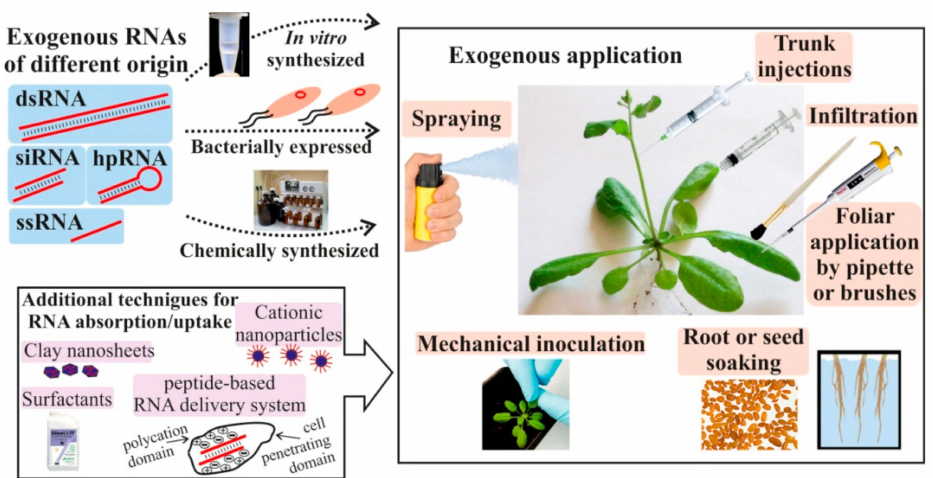
Figure 1. Schematic representation of the type (double-stranded RNA (dsRNA), small interfering RNA (siRNA), hairpin RNA (hpRNA), and single-stranded RNA (ssRNA)) and origin (in vitro, chemically, or bacterially synthesized) of externally applied RNAs and the available RNA application methods (spraying, mechanical inoculation, root or seed soaking, foliar application by pipette or brushes, infiltration, trunk injections) used for RNA delivery in plants. The artificial RNAs could be